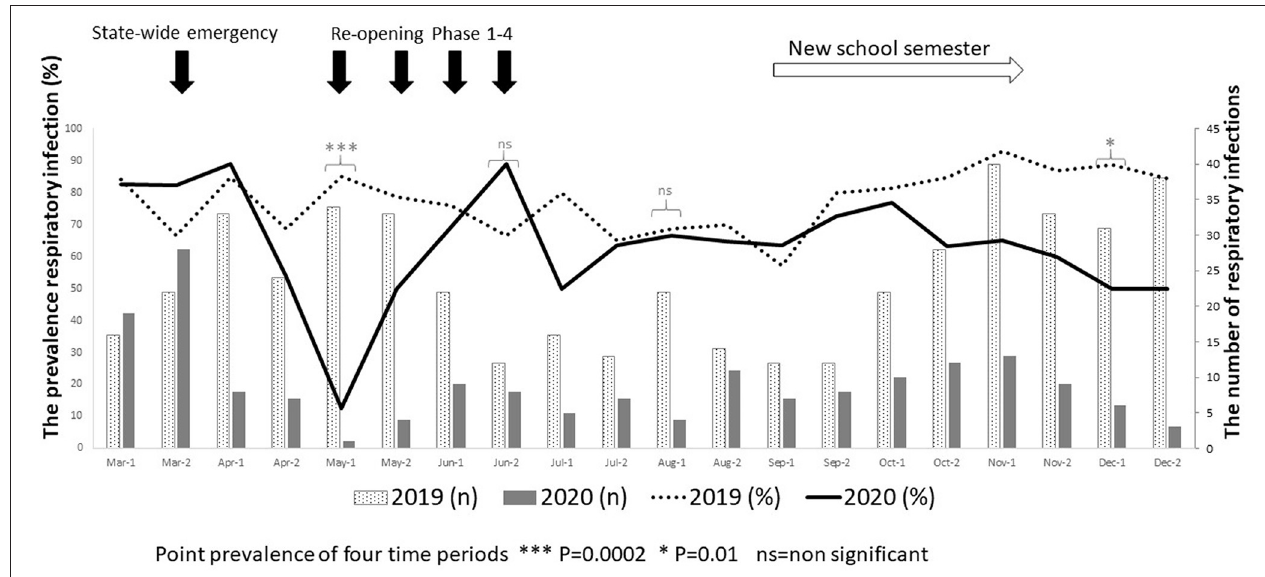
FIGURE 1 | The prevalence of respiratory infections in prepandemic (March–December 2019) and during the pandemic (March–December 2020) in children age “6–30 months.” The left Y -axis shows the percentage of respiratory infections, while the right Y -axis represents the number of respiratory infections observed in the two times. Fisher’s exact test was used to analyze for point prevalence of four time periods.